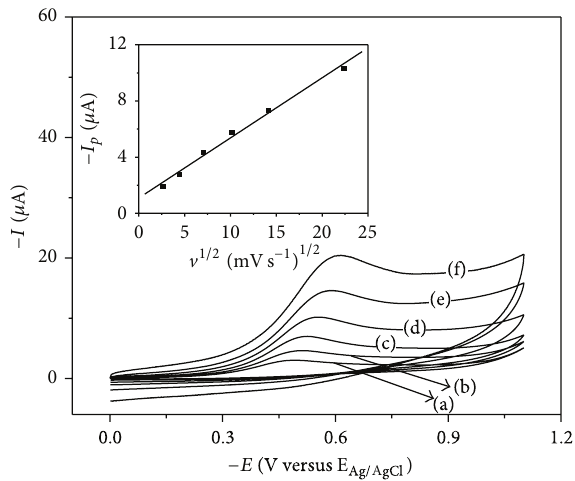
Figure 3: CV curves for 2,4-D (10.5 mg L −1 ) in 0.1mol L −1 BR buffer solution (pH 2.0). Scan rate: (a) 10, (b) 20, (c) 50, (d) 100, (e) 200, and (f) 500 mVs −1 . Inset: 𝐼 𝑝 versus V 1/2 graph ( 𝑟 2 = 0.995